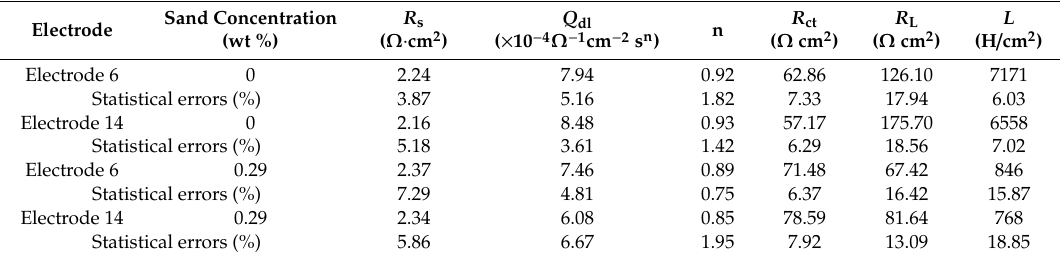
Table 1. Electrochemical parameters fitted from the electrochemical impedance spectroscopy (EIS) data of typical array electrodes 6 (outside) and 14 (inside).